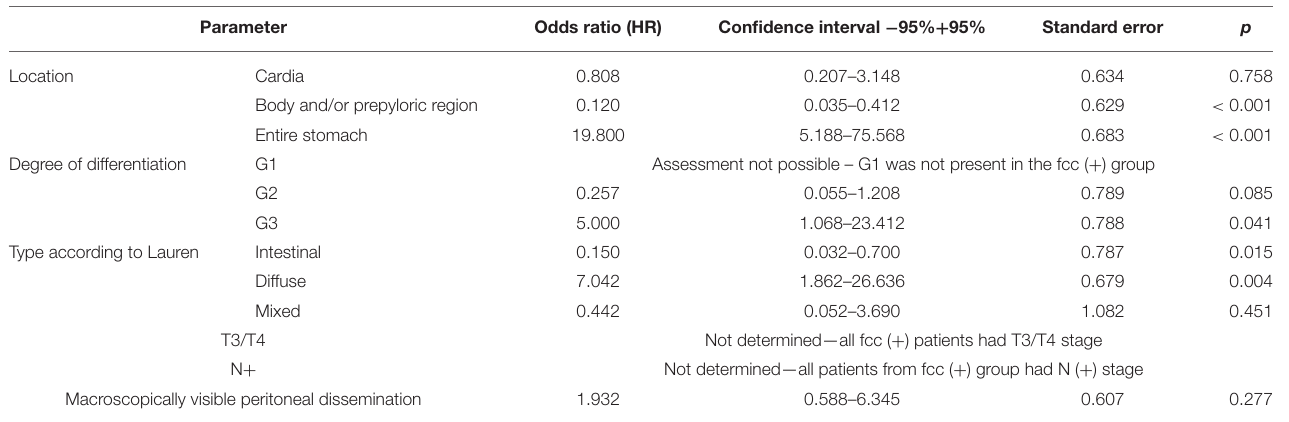
TABLE 3 | Logistic regression of parameters, which may affect the positive result of peritoneal lavage examination.